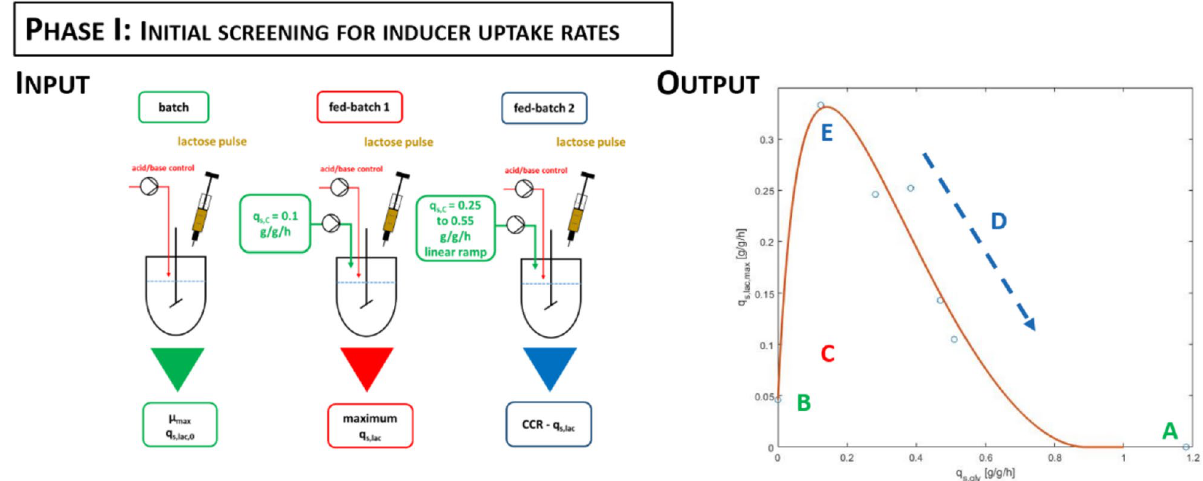
Figure 4. Phase I: Generic workflow for determination of maximum inducer uptake rates (q s ) versus primary substrate uptake rates for E. coli . Therefore three experiments are necessary: (1st step) a batch cultivation for maximum growth rate (A) and inducer uptake without C-source (B); (2nd step) fed-batch cultivation for the maximum inducer uptake rate (C) (3rd step) fed-batch cultivation for inducer uptake rates between a q s,gly set point from 0.25 to 0.55 g/g/h using a linear ramp approach to screen the regime of carbon catabolite repression (CCR)